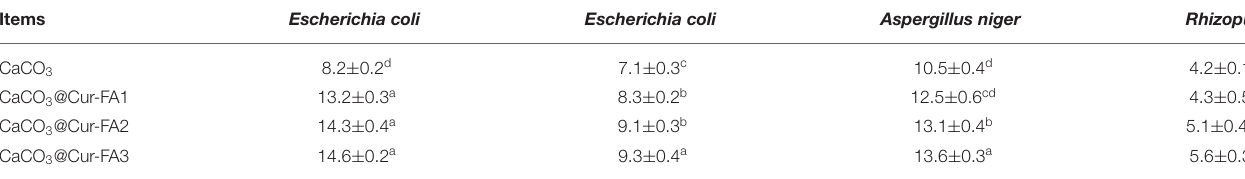
TABLE 2 | Bacteriostatic activity of films.